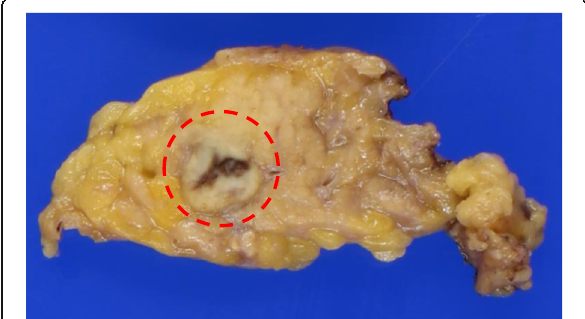
Fig. 3 Macroscopic findings of the resected specimen. A well- circumscribed whitish-yellow solid mass, measuring 7 mm at the greatest dimension, was located in the pancreatic tail